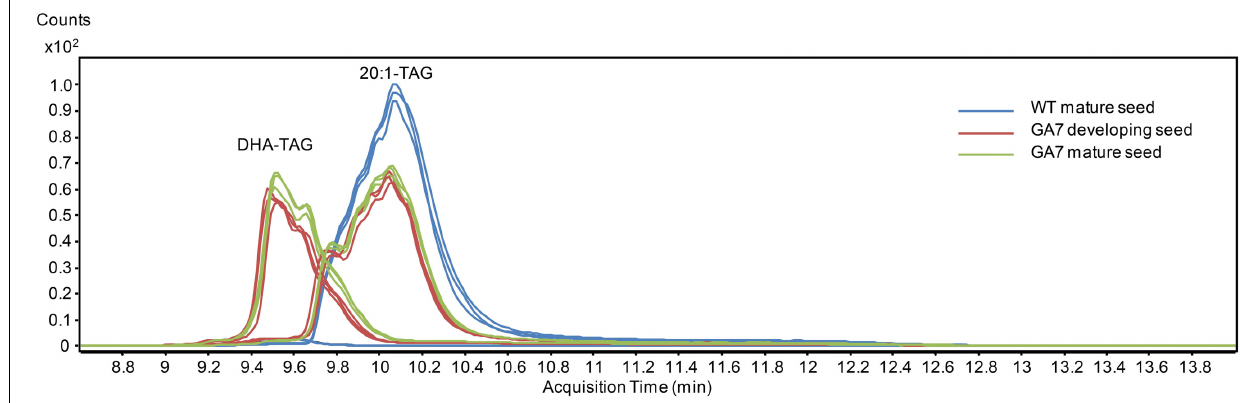
Frontiers in Plant Science | Plant Metabolism and